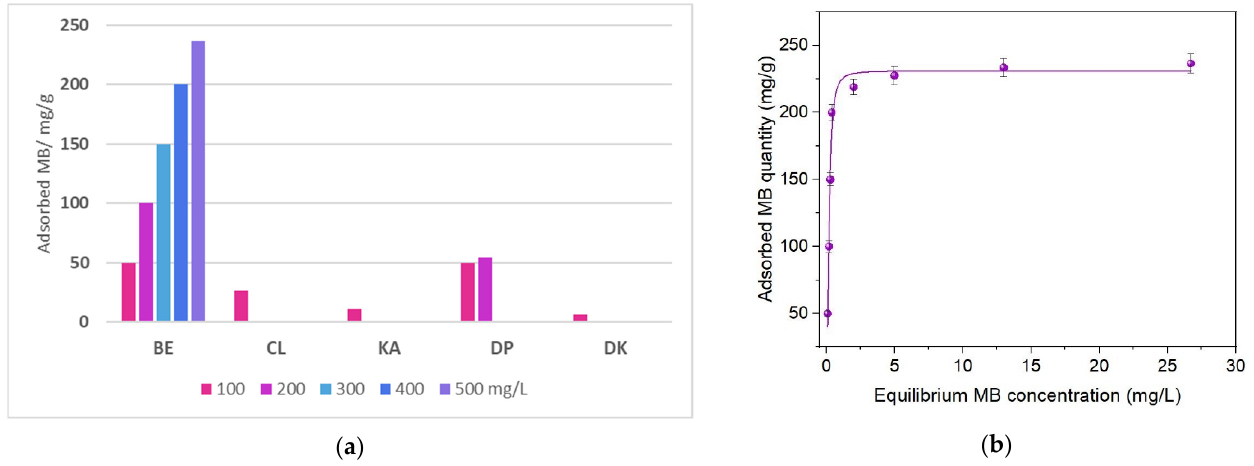
Figure 2. Retained quantities of MB on investigated minerals, recorded for different initial MB concentra- tions ( a ); Langmuir–Freundlich adsorption isotherm for MB adsorption on bentonite sample ( b